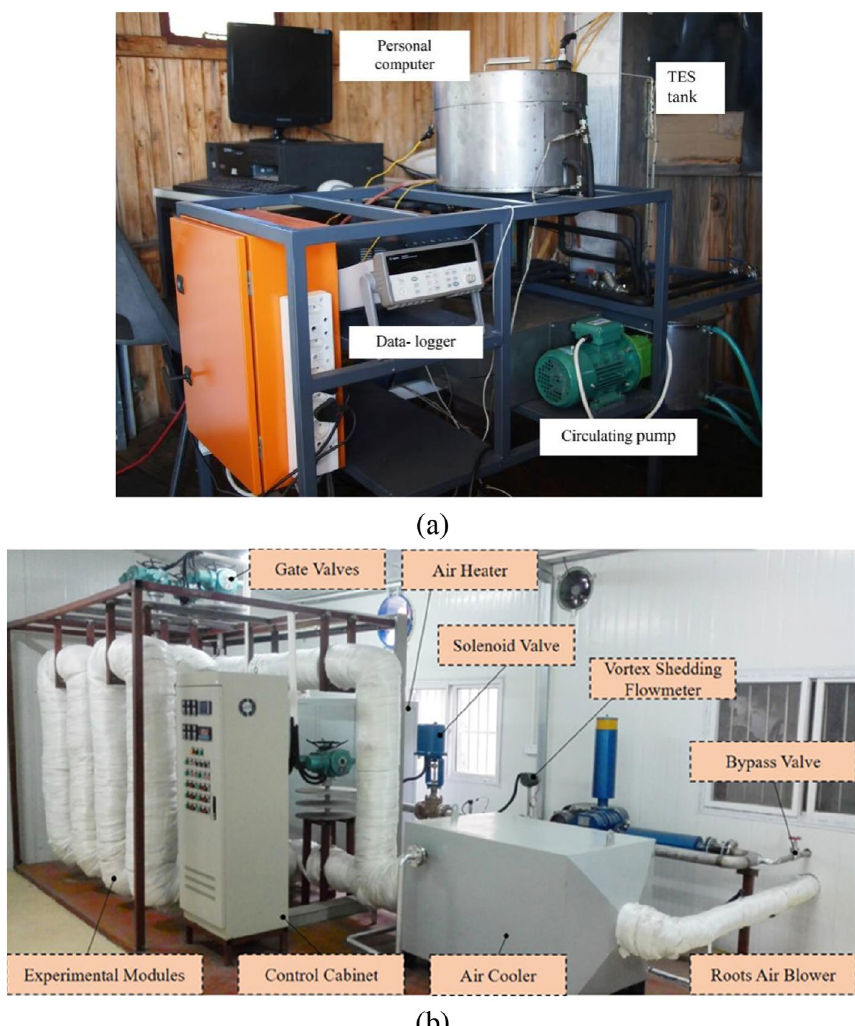
Fig. 6 Representative lab-scale experimental CLHS systems: a Mawire et al.’s CLHS system, and b Yuan et al.’s CLHS system [142,